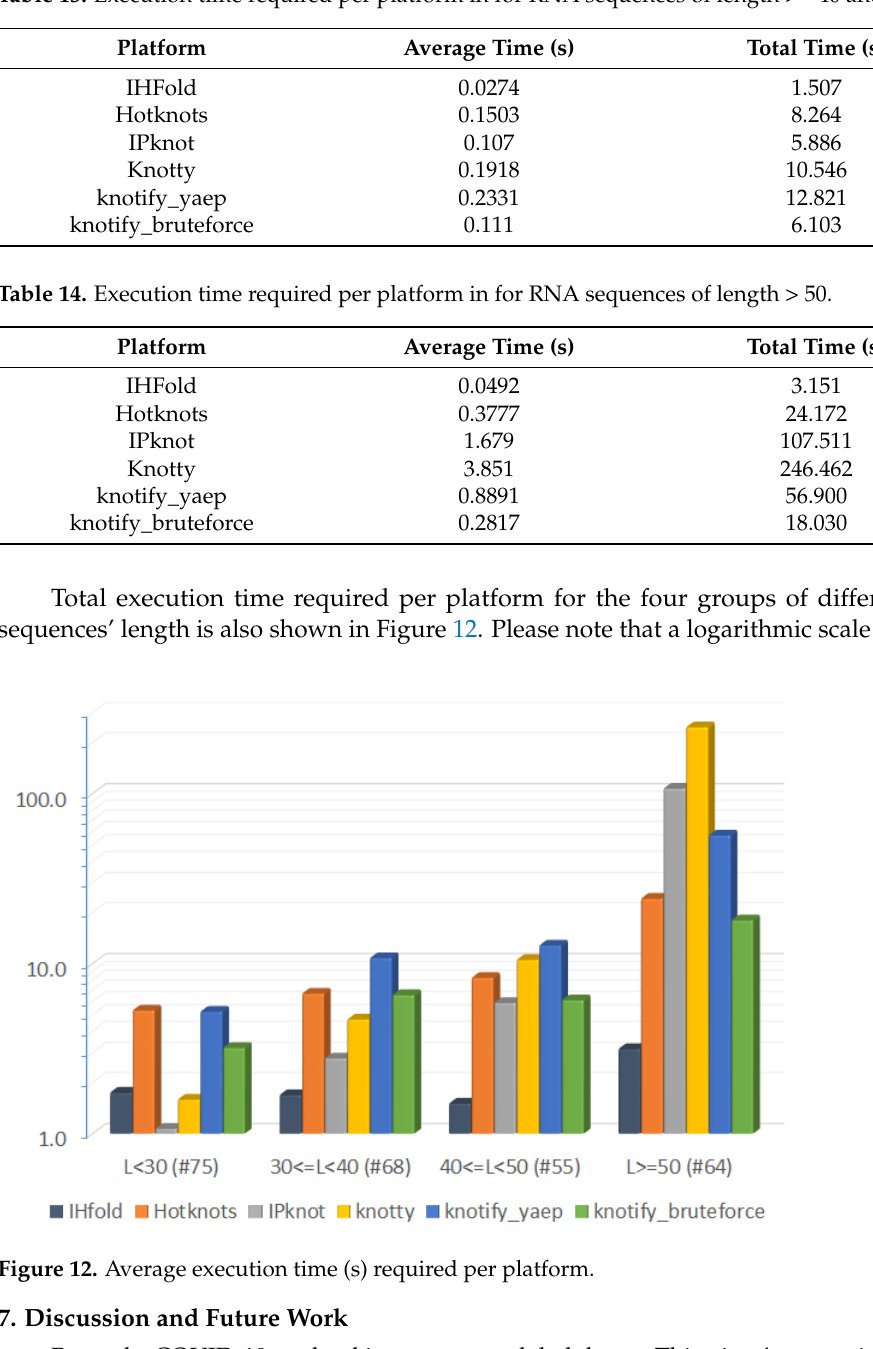
Table 13. Execution time required per platform in for RNA sequences of length >= 40 and < 50.